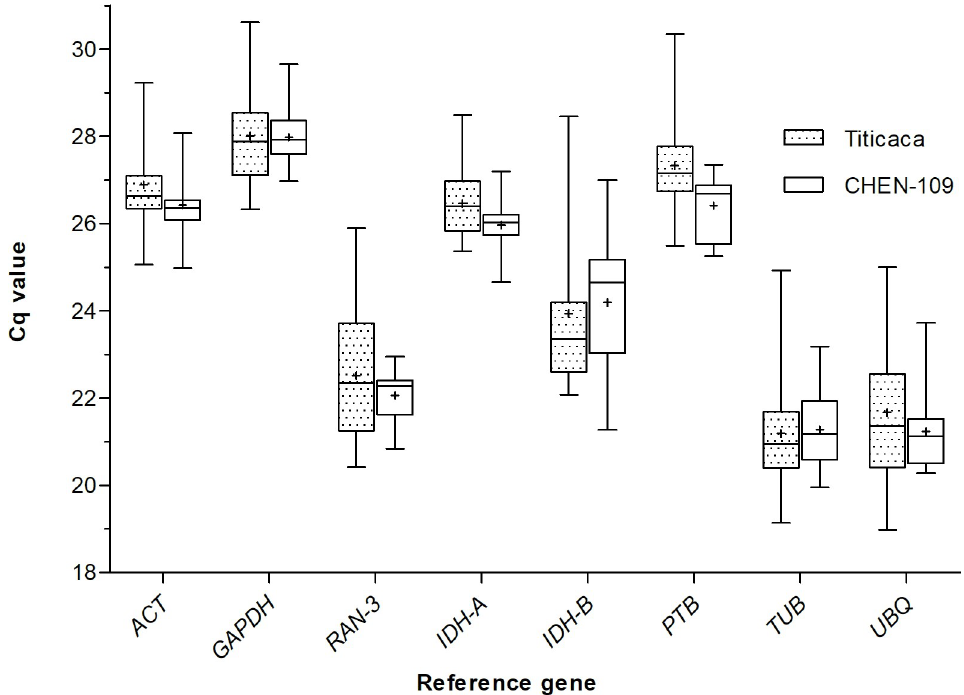
Fig 1. Variation in Cq values of the candidate genes. Cq values were calculated as means of triplicate technical replicates across the 21 diurnal/circadian samples. The median values are represented as lines across the box. The lower and the upper boundaries of each box represent the 25th and 75th percentile, respectively. Whiskers represent the maximum and minimum values. The mean is represented by crosses inside the boxes.